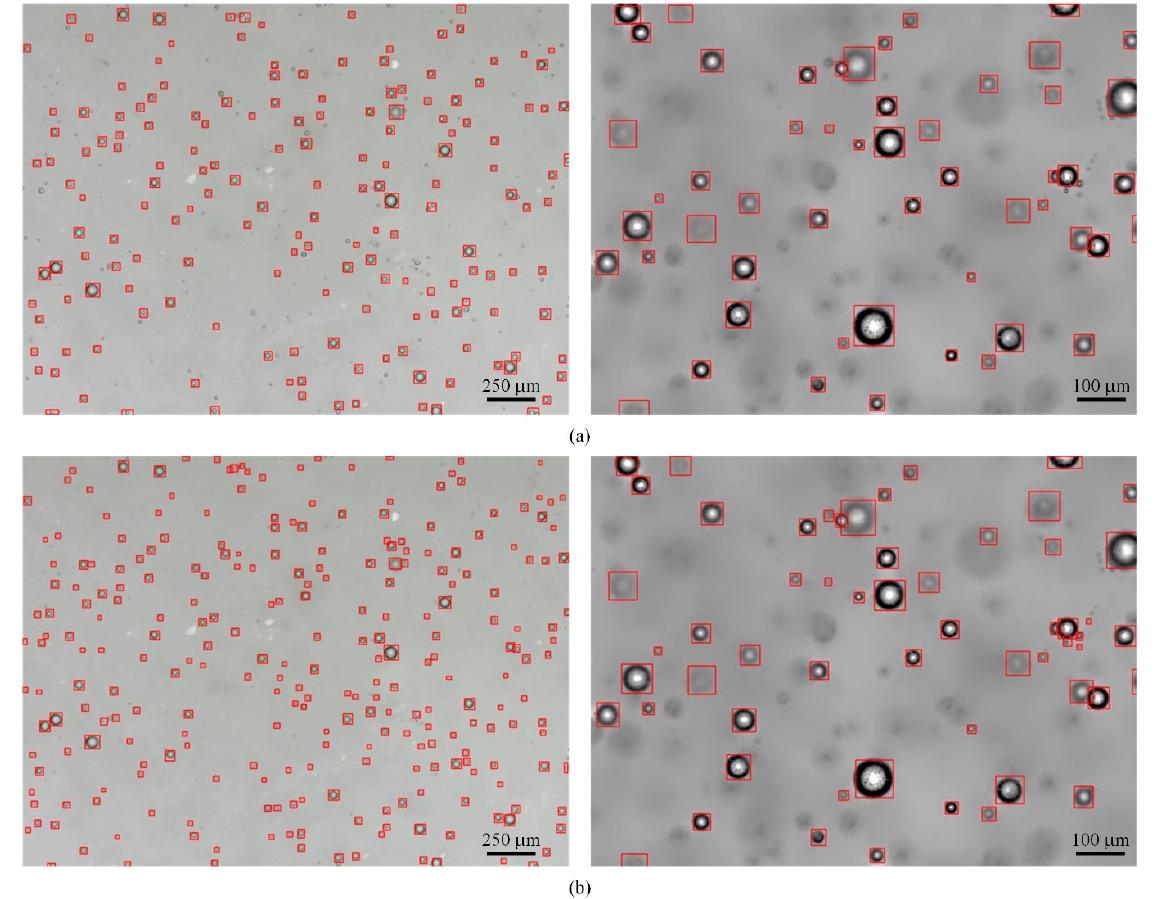
Figure 12. Comparison of visual graphs of test results. ( a ) The results of YOLOv5s testing; ( b ) The results of YOLO-QCB testing. Table 6. Results of testing the proposed algorithm on several video